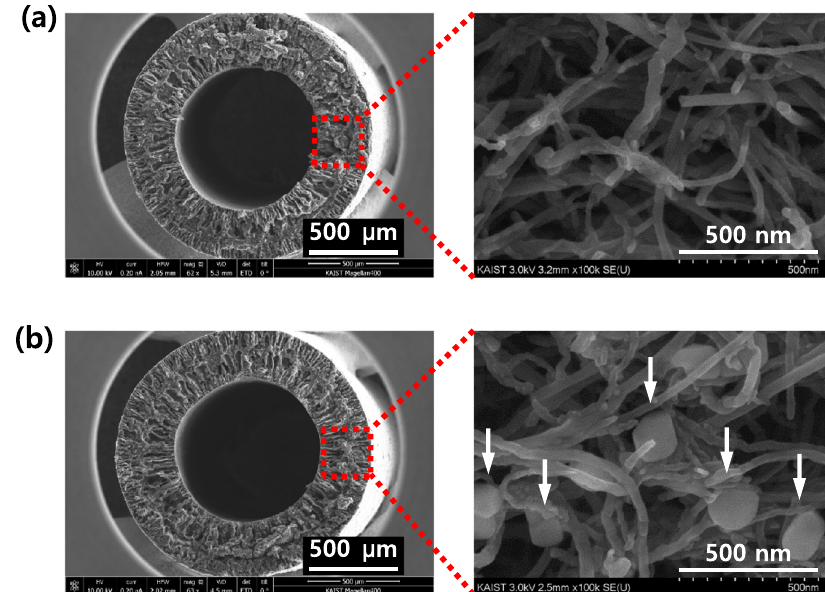
Fig. 1 SEM images at various magni fi cations. a CHF and b NTP-CHF.